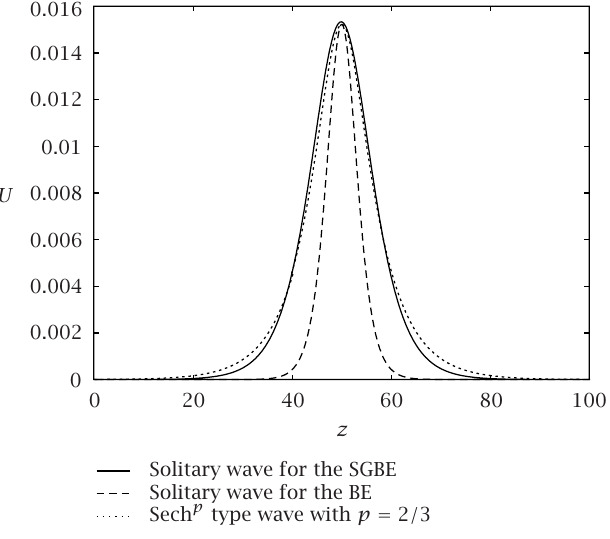
Figure 3.2. Comparison for the solitary waves of the Boussinesq equation and the SGBE.